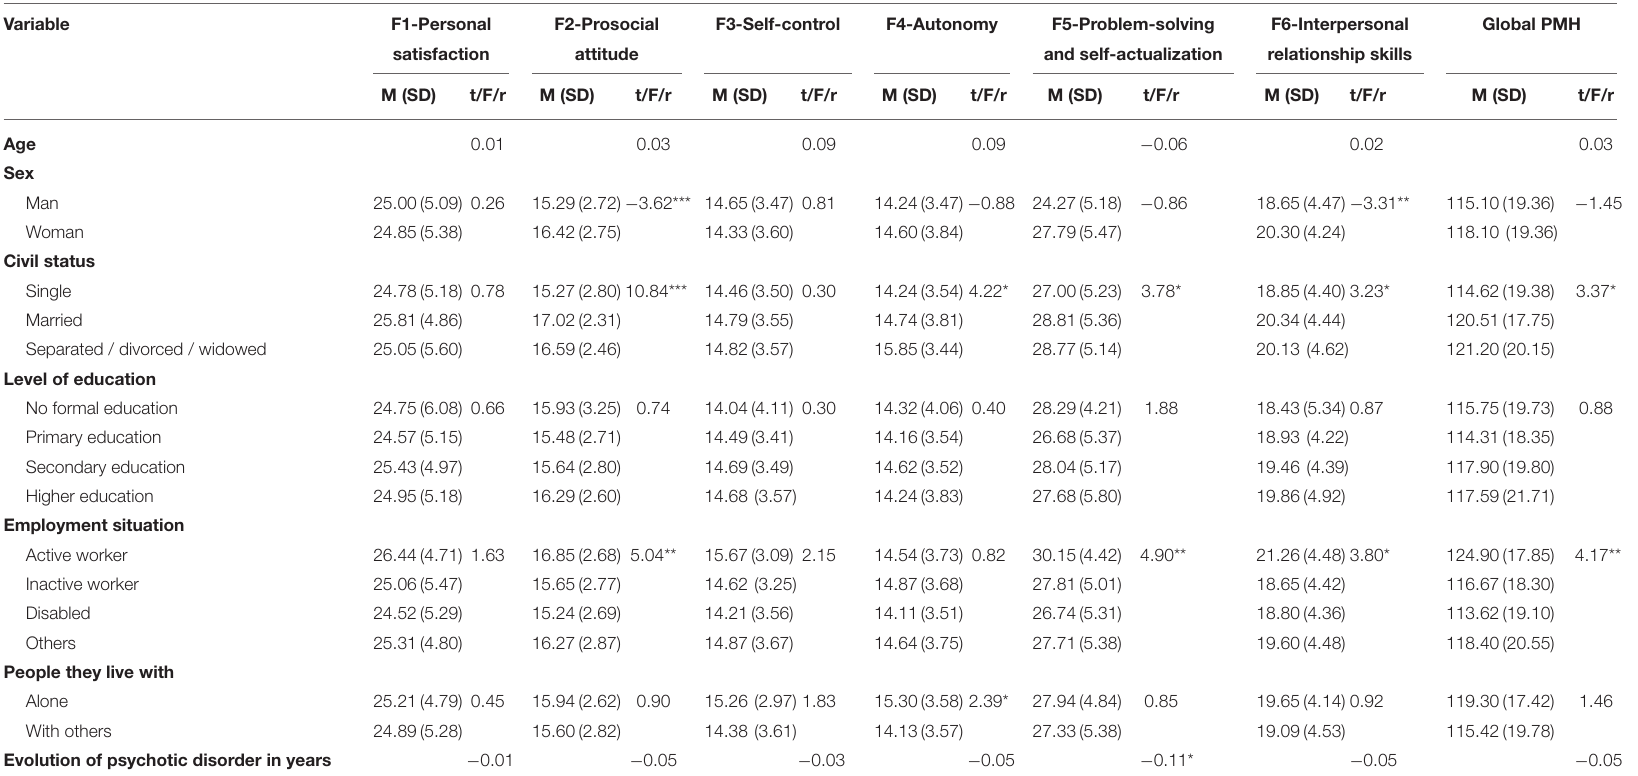
TABLE 2 | Relationship between global PMH and by factors and sociodemographic and clinical